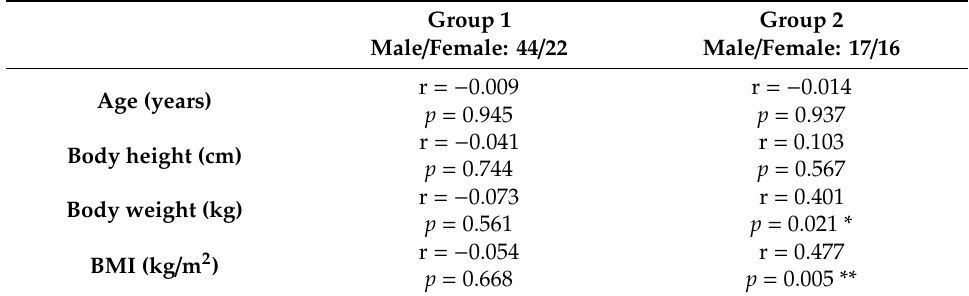
Table 3. Pearson correlations between the instantaneous frequency di ff erence ∆ f Emax and demographic and anthropometric parameters in young and upper middle-aged